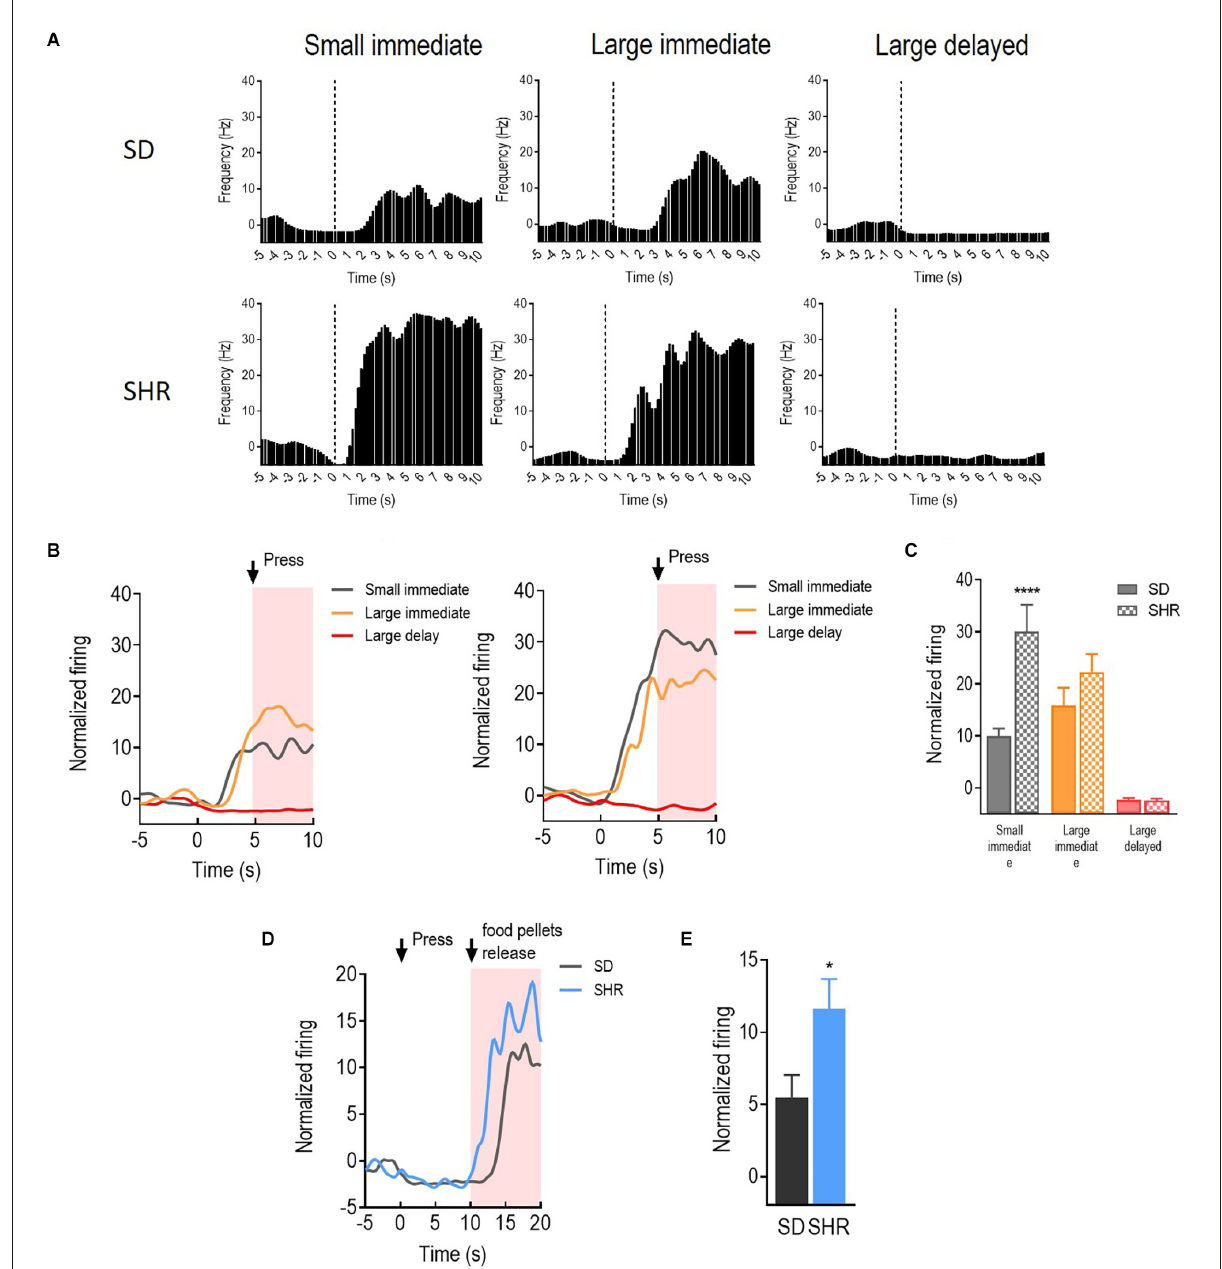
FIGURE2 The orbitofrontal cortex (OFC) neurons respond to reward in SD and SHR rats. (A) Peri-event histograms of representative OFC neurons in SD rats (upperpanel)andSHRrats(lowerpanel)inresponsetothesizedreinforcer.Dataarealignedtorewardonset(leverpressingattime0,dashedline). (B) Normalized firing response of all OFC neurons response to sized reinforcer in SD rats (left panel) and SHR (right panel) rats. (C) Quantification of the normalized firing rate of OFC neurons in both SD and SHR rats during the 5 s period after the lever press (highlighted box). (D) Normalized firing rate of all OFC neurons’ response to large delayed reinforcer in SD and SHR rats. (E) Quantification of the normalized firing rate of OFC neurons in both SD and SHR rats during the 5 s period after the release of the large delayed reinforcer. * p < 0.05, **** p < 0.0001 compared with SD